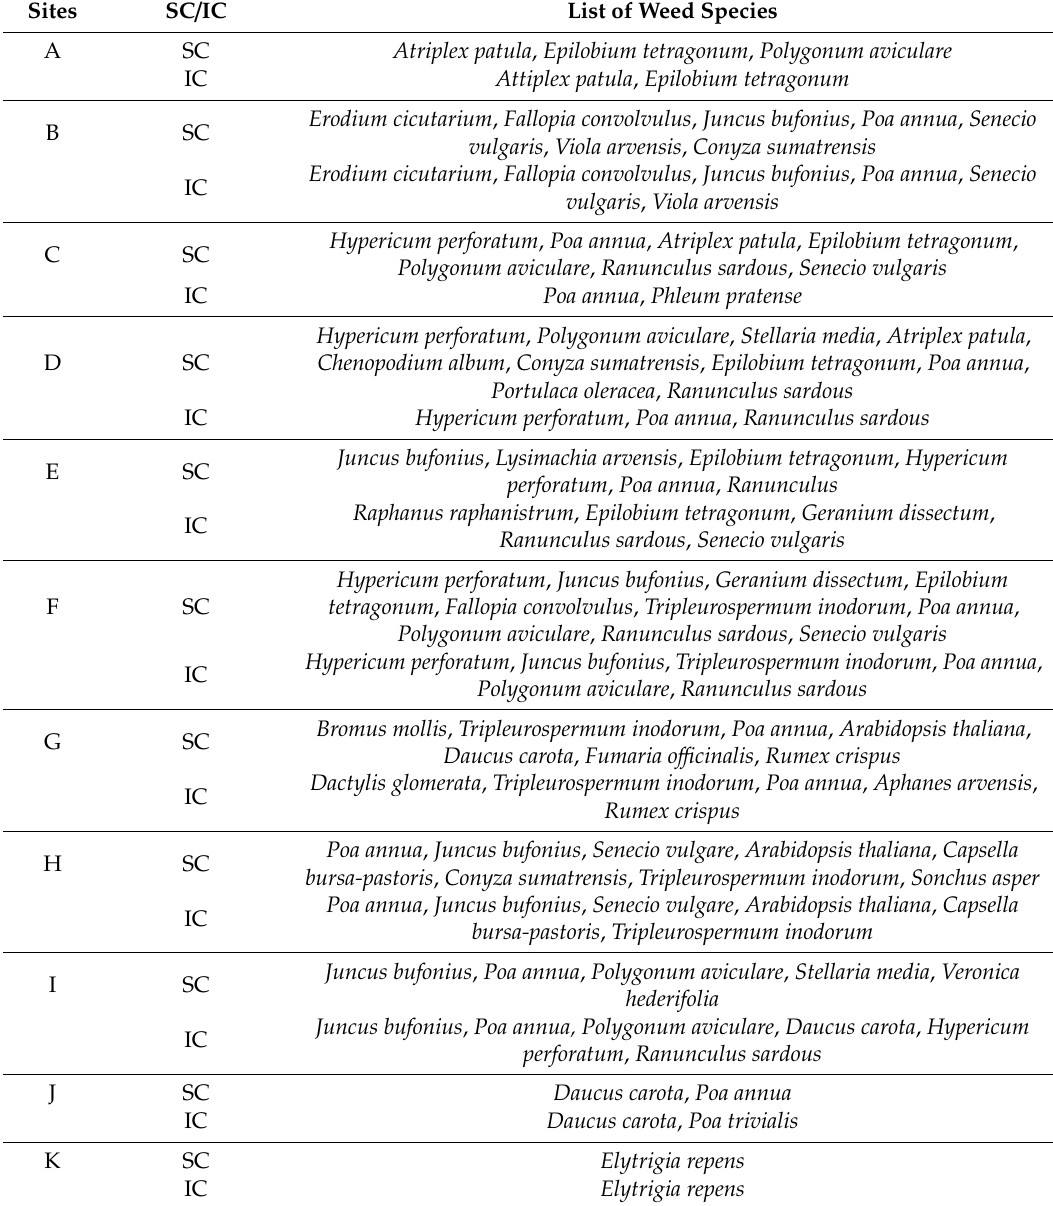
Table 3. List of weed species (species present with more than one plant per m 2 in at least one third of the subplots at lupin flowering) in lupin sole crops (SC) and intercrops